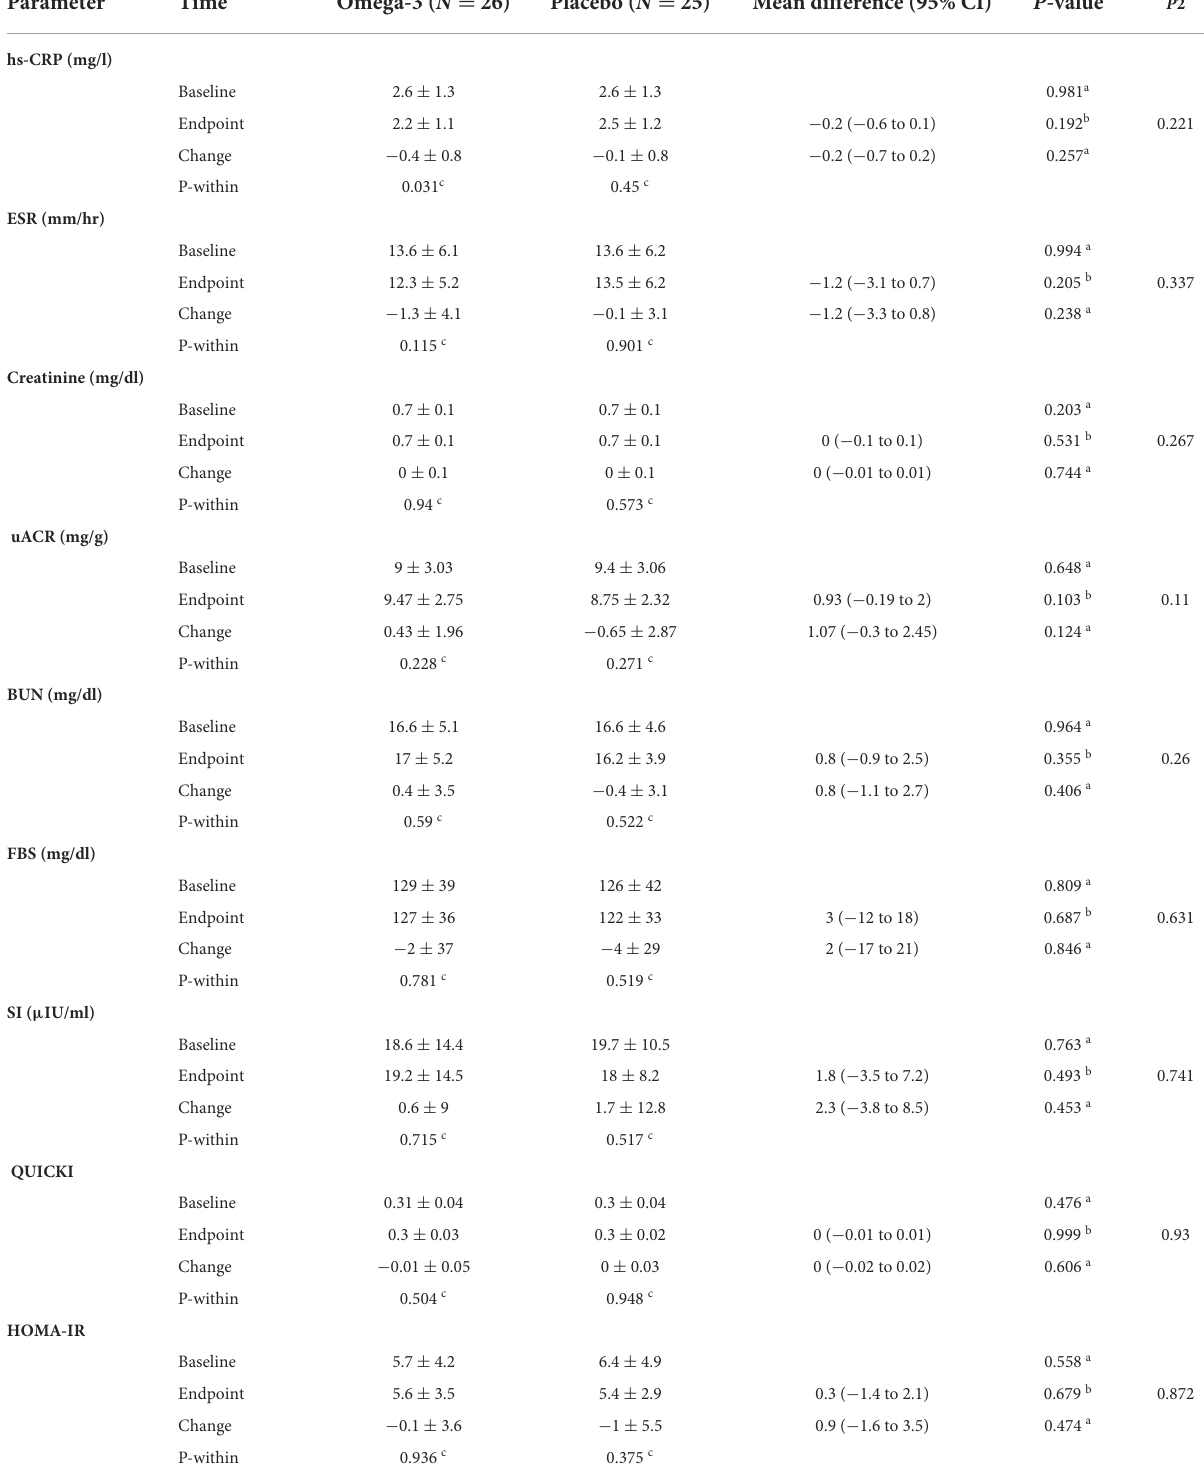
TABLE 3 Metabolic parameters before and after treatment with